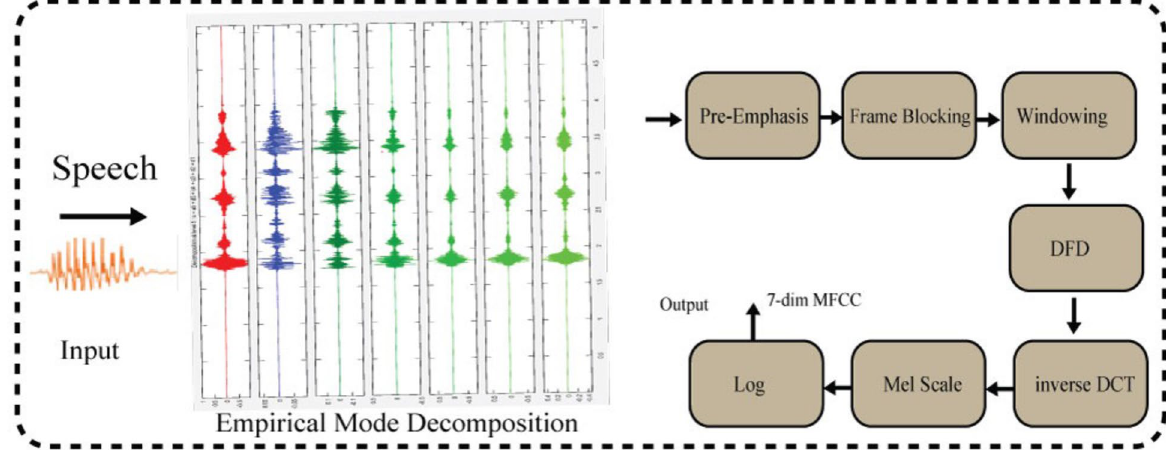
The fc , minBW , EarQ , and n represent the filter central frequency, lowest bandwidth at zones of lower frequen- cies, asymptotic quality at higher frequency zones,